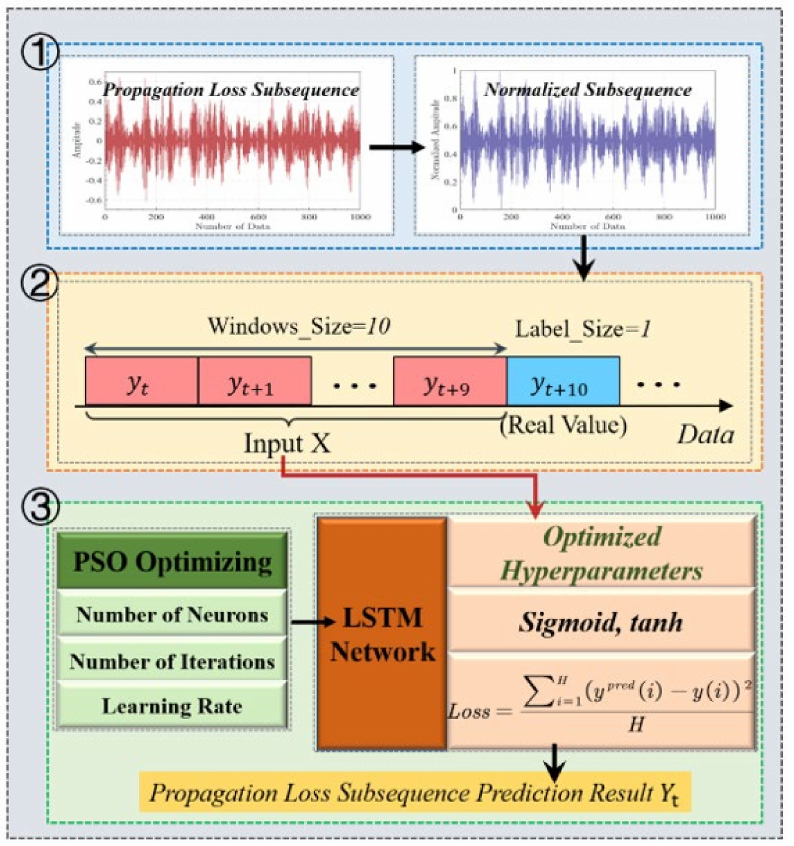
Figure 12. Modeling process for PL subsequence prediction model based on optimized LSTM network. (1) Normalizing PL subsequence; (2) setting prediction window to construct training and test sets; (3) using optimized LSTM network for